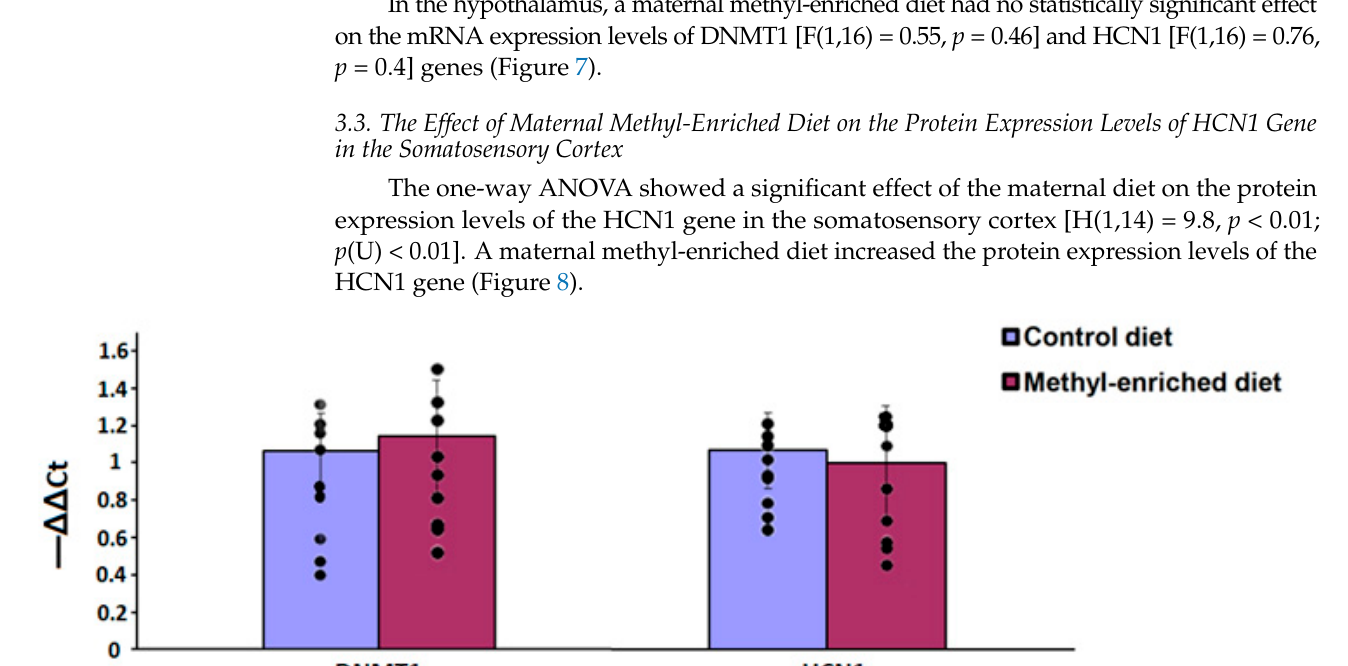
Figure 7. The mRNA expression levels of DNMT1 ( a ) and HCN1 ( b ) genes in the hypothalamus in adult offspring of WAG/Rij rats born to mothers fed a methyl-enriched or control diet. Expression of the DNMT1 and HCN1 mRNA were determined by real-time qPCR in 9 pairs of tissue samples from the control ( n = 10 rats) and experimental ( n = 10 rats) group of animals. Data are the mean ± S.E.M. The individual data points are displayed in bar graphs to show within-group variability.